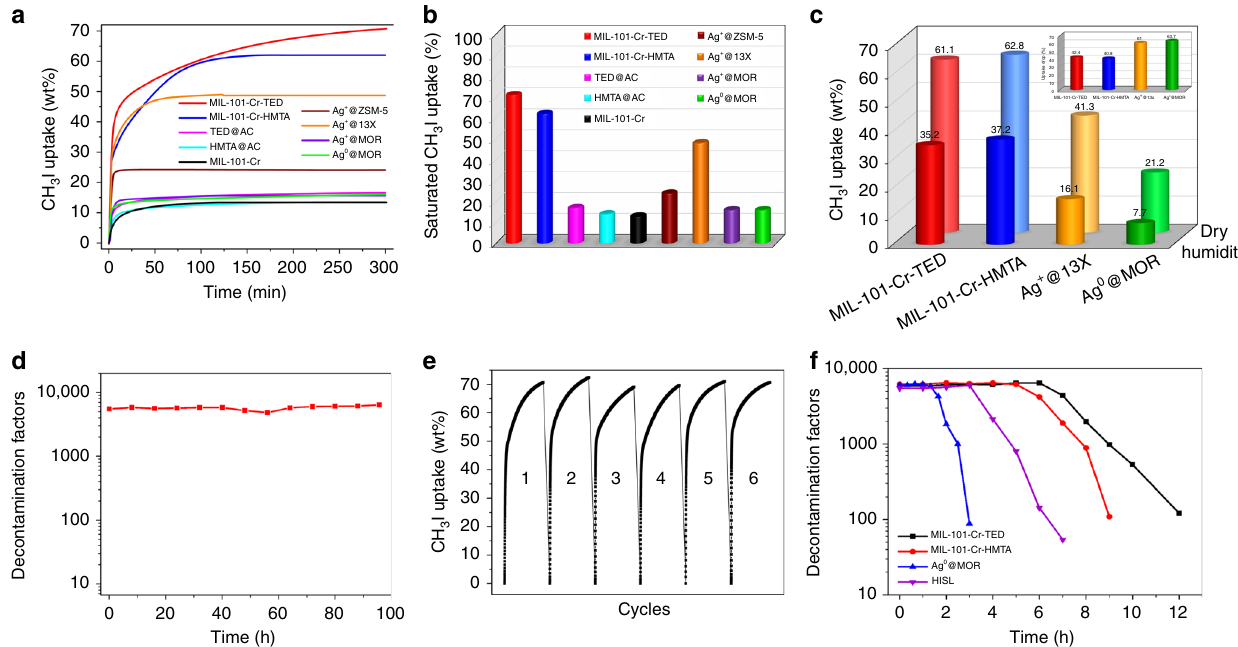
Fig. 3 The CH 3 I capture performance. a Sorption isotherms of CH 3 I in MIL-101-Cr-TED, MIL-101-Cr-HMTA, and selected benchmark sorbent materials at 150 °C with partial pressure of 0.2 atm for CH 3 I. b Comparing the saturated CH 3 I uptake in MIL-101-Cr-TED, MIL-101-Cr-HMTA, and selected benchmark sorbent materials at 150 °C with partial pressure of 0.2 atm for CH 3 I. c The CH 3 I uptake at 150 °C under dry and humidity (RH = 81%) conditions by breakthrough experiment ( back row : dry conditions; front row : humid conditions), ( insert ) the uptake drop ratio by comparing the CH 3 I uptake of dry and humid conditions. d Decontamination factors of CH 3 I by MIL-101-Cr-TED under simulated conditions representing gas mixtures produced during CH 3 I reprocessing, which include CH 3 I (50 ppm), H 2 O, HNO 3 , NO 2 , and NO at 150 °C. e The recyclability of MIL-101-Cr-TED for CH 3 I capture. f Decontamination factors of total iodine (CH 3 I and I 2 ) by MIL-101-Cr-TED, MIL-101-Cr-HTMA, and comparable samples Ag 0 @MOR and HISL under